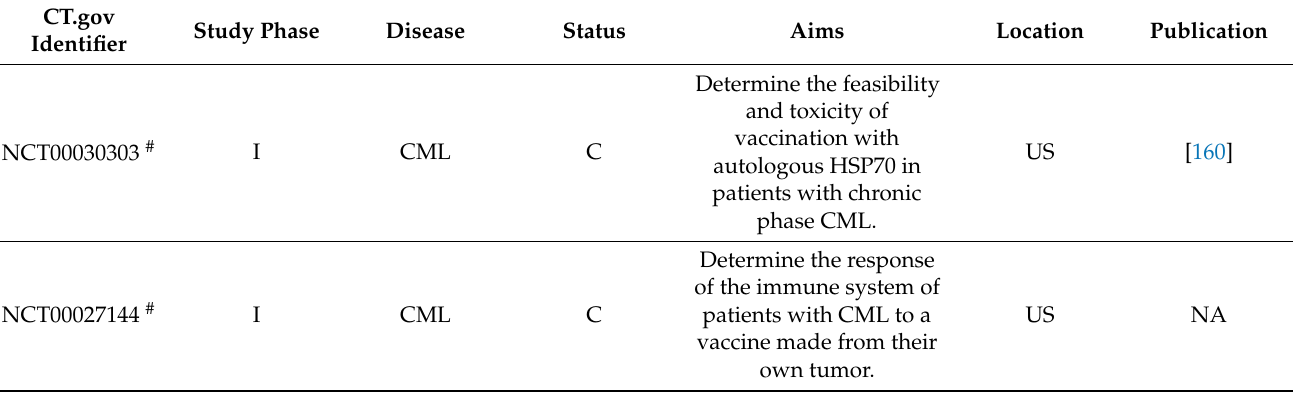
Table 2. Clinical trials about HSP70 in hematological malignancies. Data have been obtained from https://clinicaltrials.gov/ and PubMed (accessed on 25 February